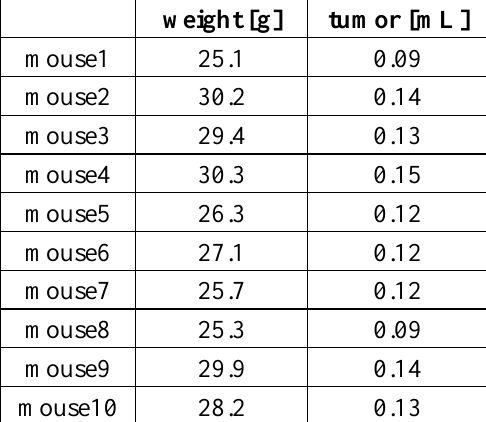
Table 1. Mice weights and tumor